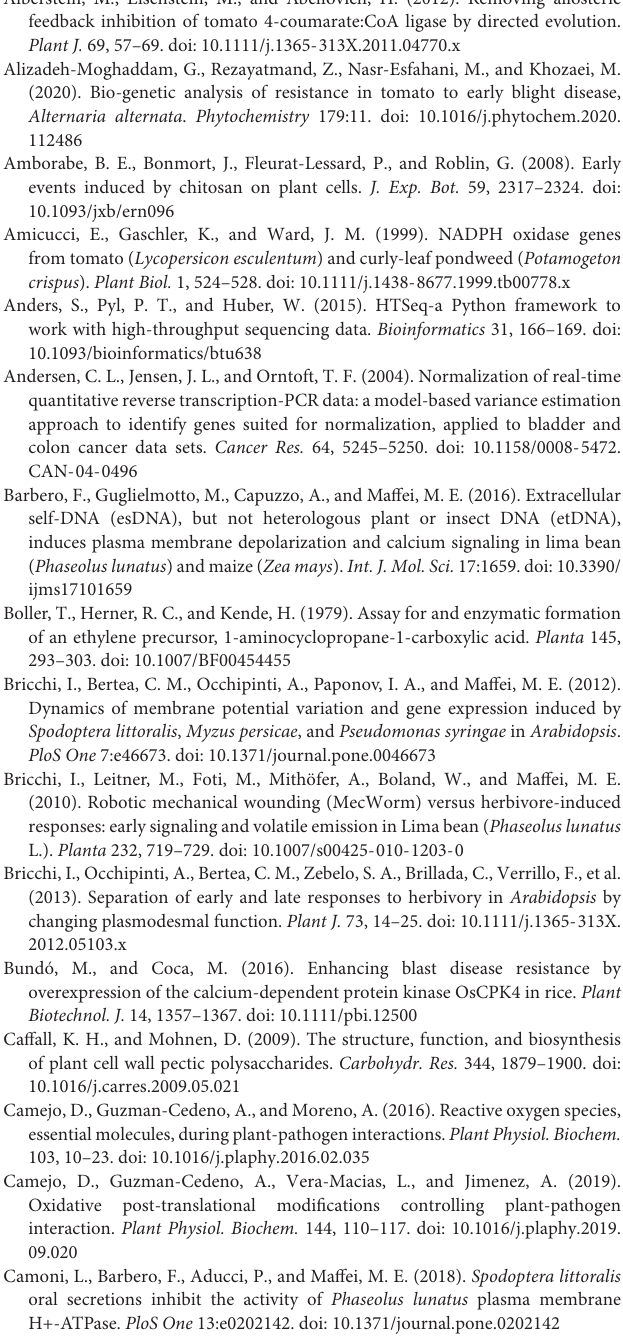
Supplementary Figure 4 | Hierarchical clustering by comparing the genes upregulated in response to eDNA against the Genevestigator database of S. lycopersicum . Supplementary Figure 5 | Hierarchical clustering of the expression potential of genes downregulated in response to eDNA against the S. lycopersicum database of Genevestigator.